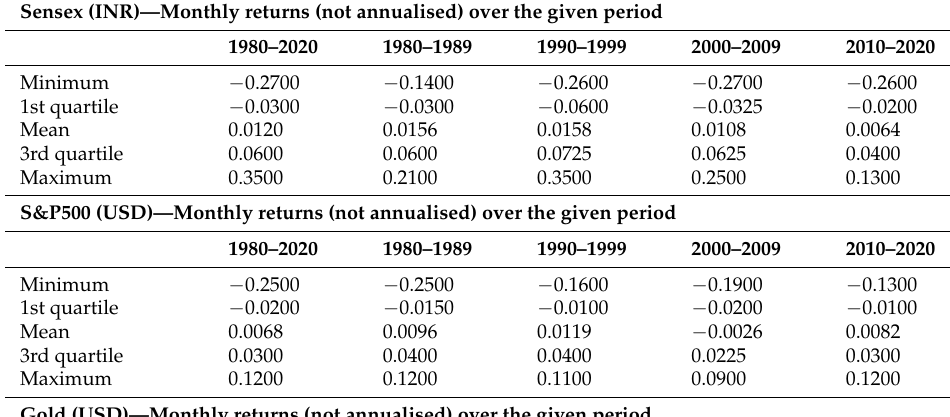
Sensex (USD) GOLD ($/troy oz) S&P500 Chart 1. Stock indices and gold prices. Sources: BSE-India, World Bank, Yahoo.com (accessed on 20 Table 2. Summary statistics of monthly (not annualised) returns. Table 2. Summary statistics of monthly (not annualised) returns. Sensex (INR)—Monthly returns (not annualised) over the given